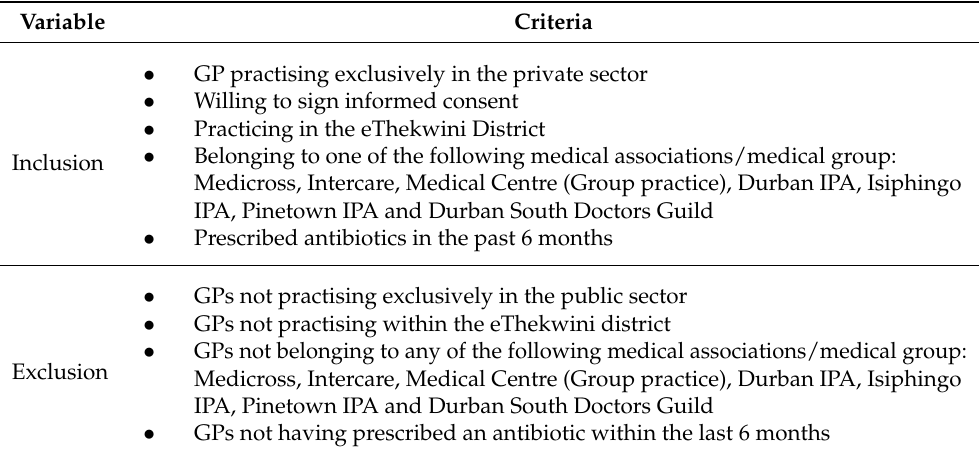
Table 2. Inclusion and exclusion